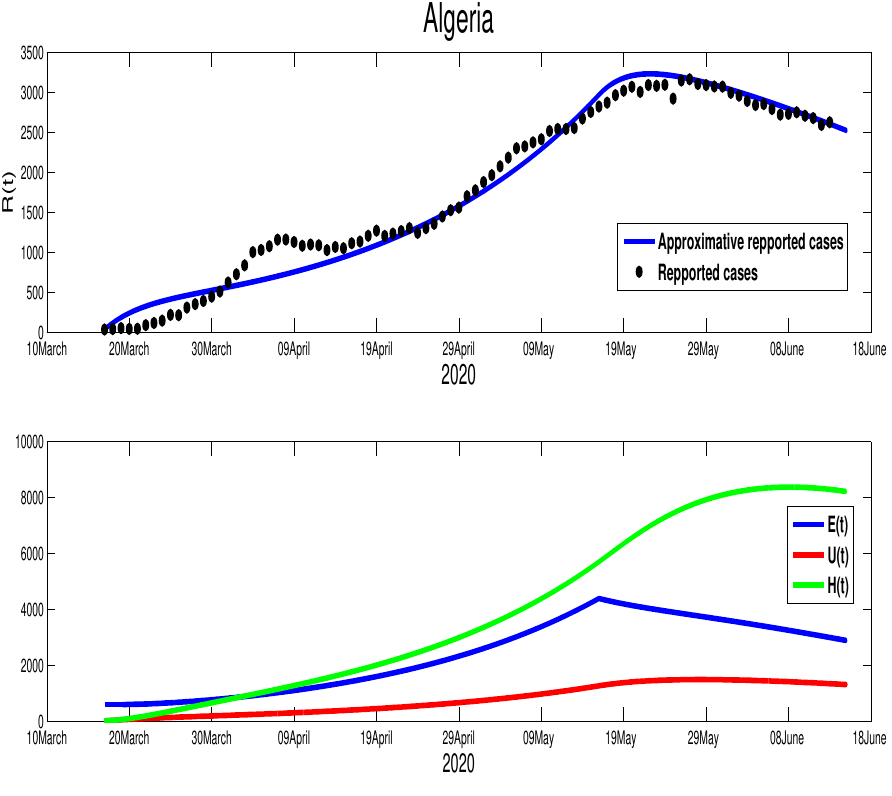
Figure 4. The data fitting of the reported COVID-19 cases in Algeria and prediction of the other variables of our